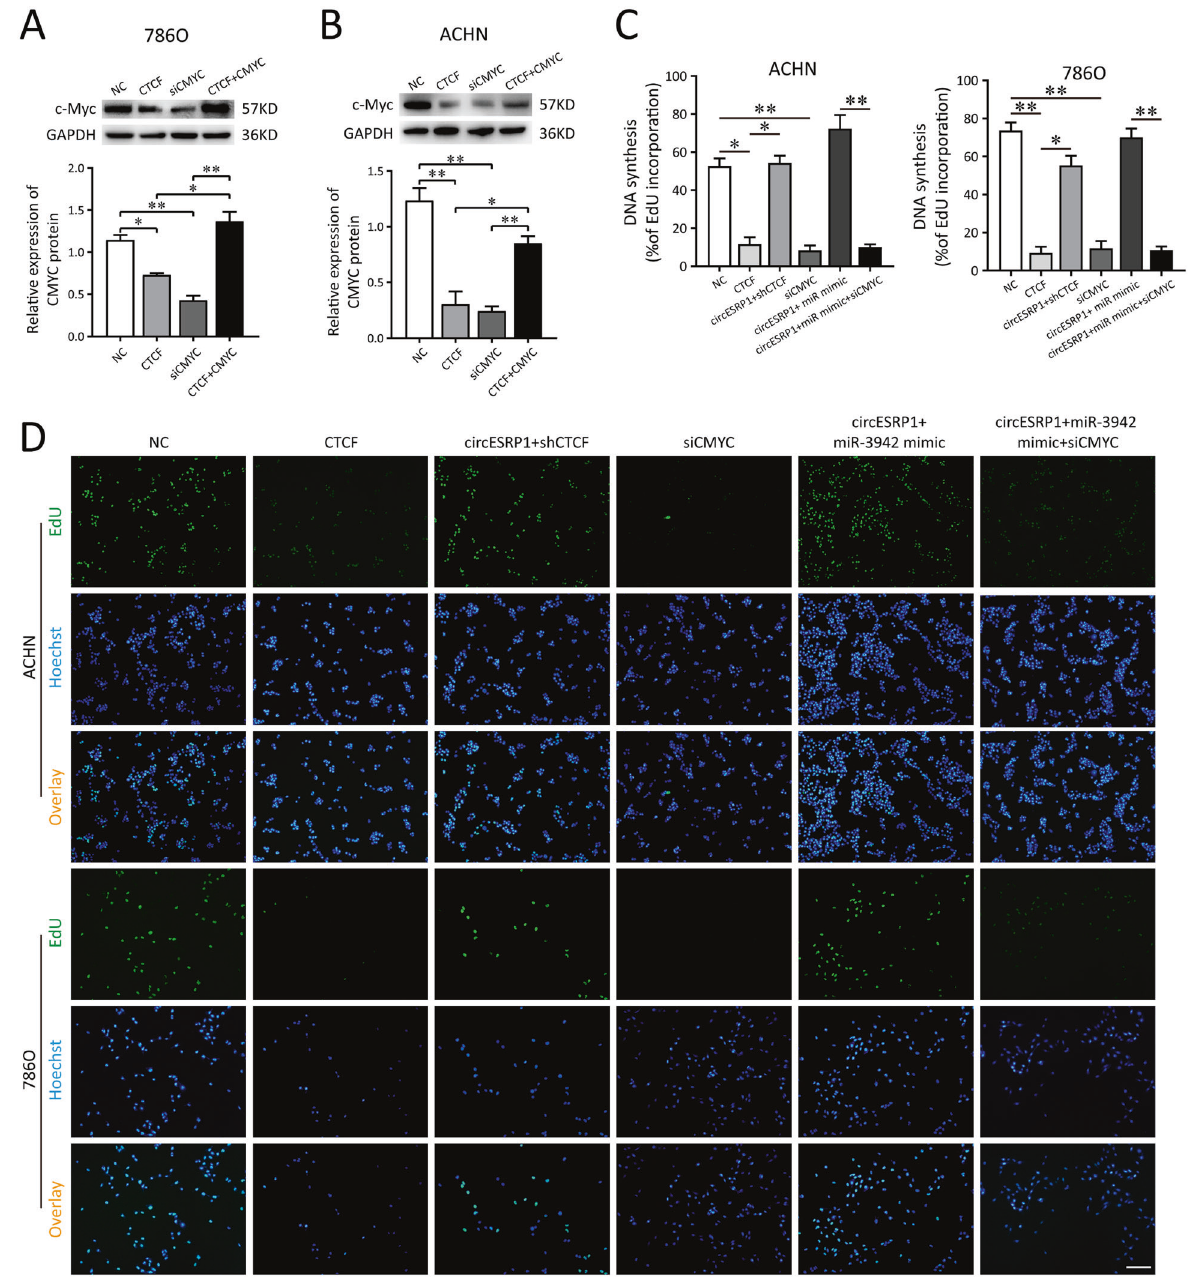
Fig. 6 circESRP1 prohibits ccRCC proliferation via miR-3942/CTCF axis and c-Myc. A , B Western blot analysis showed the c-Myc protein level in the transfection of CTCF overexpressed plasmid with or without CMYC overexpression in ccRCC cells (786O, ACHN). C , D The DNA synthesis of 786O and ACHN cells was tested by EdU assay with the transfection of CTCF overexpressed plasmid (CTCF), CTCF shRNA (shCTCF), circESRP1-overexpressing lentivirus plasmid (circESRP1), c-Myc siRNA (si-c-Myc), and miR-3942 mimic. The data are presented as the mean ( n = 3) ± SEM. * p < 0.05; ** p <